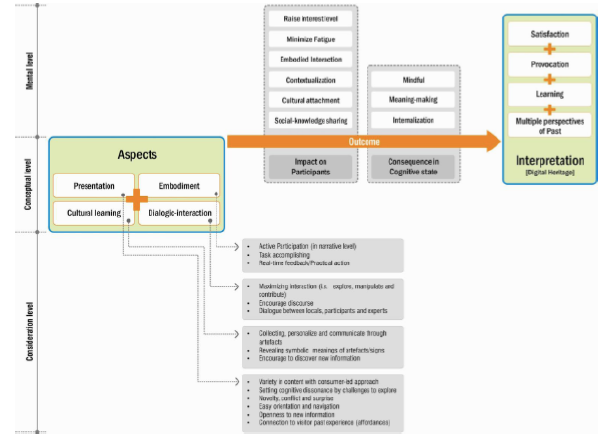
Figure 12. Framework for Interpreting Digital